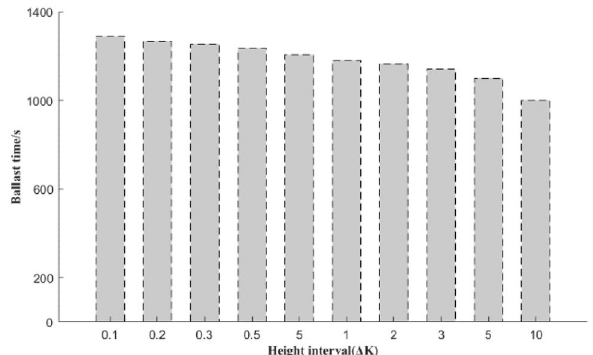
Figure 17. Comparison of different ∆ K